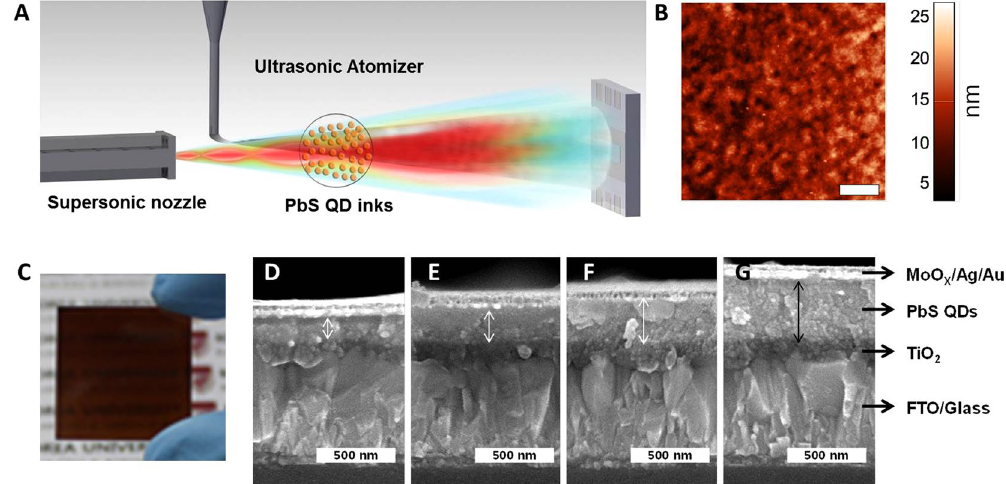
Figure 3. ( A ) Schematic of spray deposition of PbS QD ink. ( B ) AFM image (scale bar represents 1 µ m), ( C ) photographic image, and ( D – G ) cross-sectional SEM images (scale bars represent 500 nm) of PbS QD